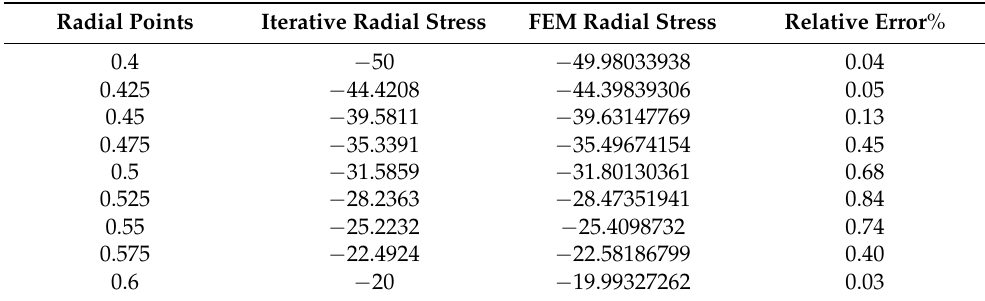
Table 2. Comparison of radial stress in FGM cylinder using iterative technique and FEM under internal pressure, P a = 50 MPa and external pressure, P b = 20 MPa.